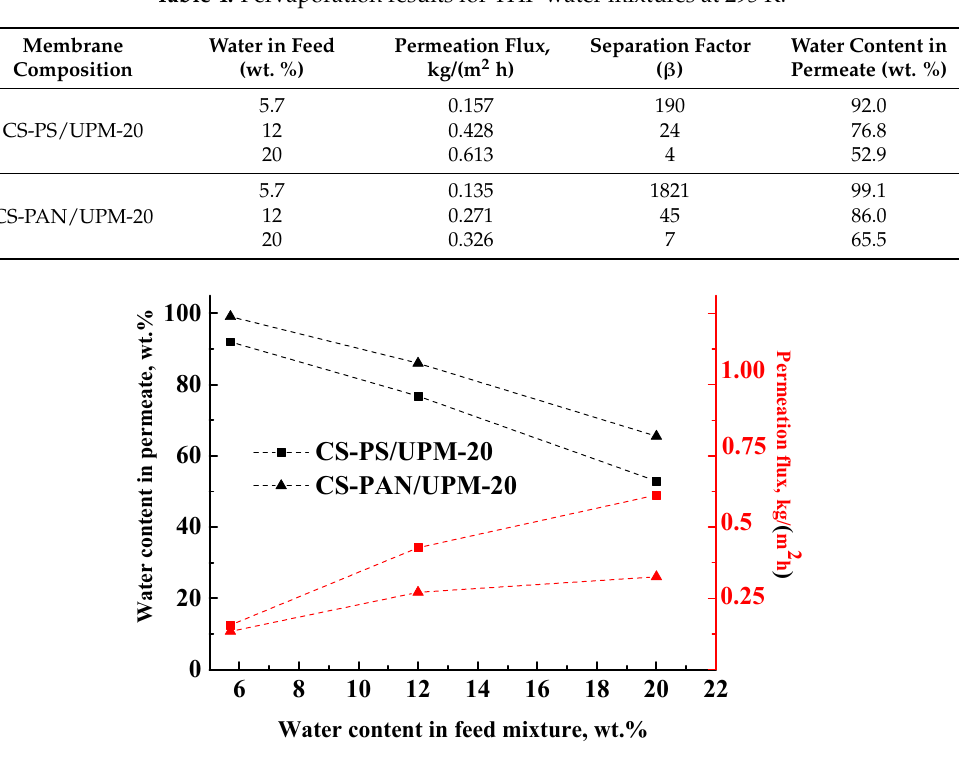
Figure 7. The dependence of water content in permeate and permeation flux on water content in the feed in pervaporation of THF-water mixture by composite membranes based on CS-PAN and CS-PS copolymers at 295 К .